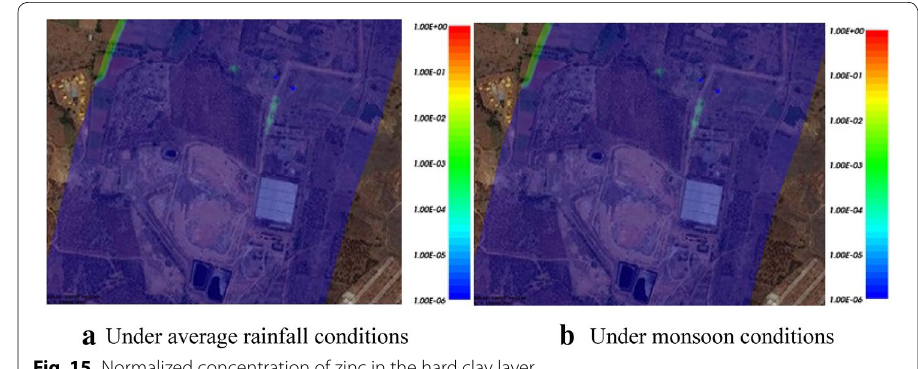
Fig. 15 Normalized concentration of zinc in the hard clay layer